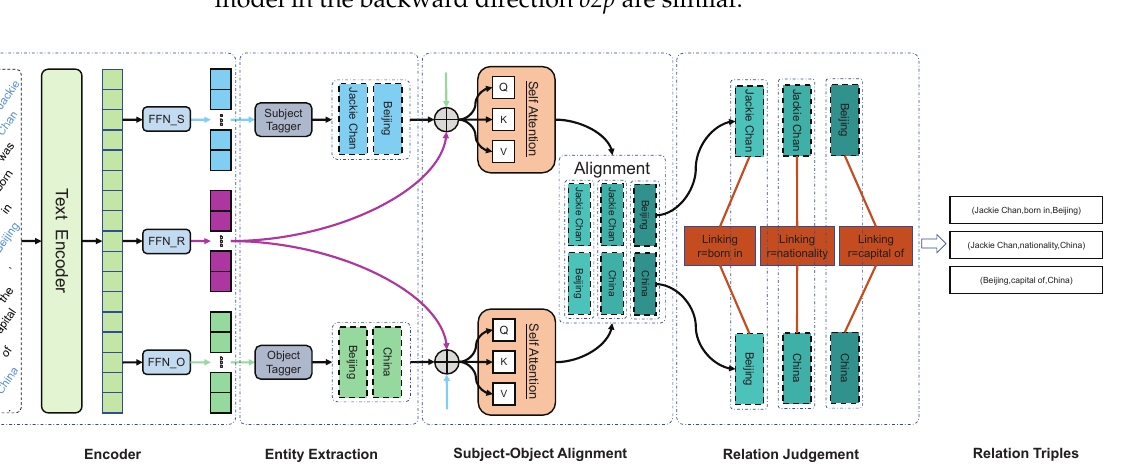
Figure 2. The structure of our the proposed approach, displaying the processing for handling one sentence that contains three relational triples (Jackie Chan, born in, Beijing) , (Jackie Chan, nationality, China) , and (Beijing, capital of, China) . In this example, BTDM first identifies entity pairs by translating and decoding in both directions, and then aligns them. Then, the relation is judged by linking a (entity pairs–relations) bipartite graph. Please note that all invalid links have been removed for the sake of